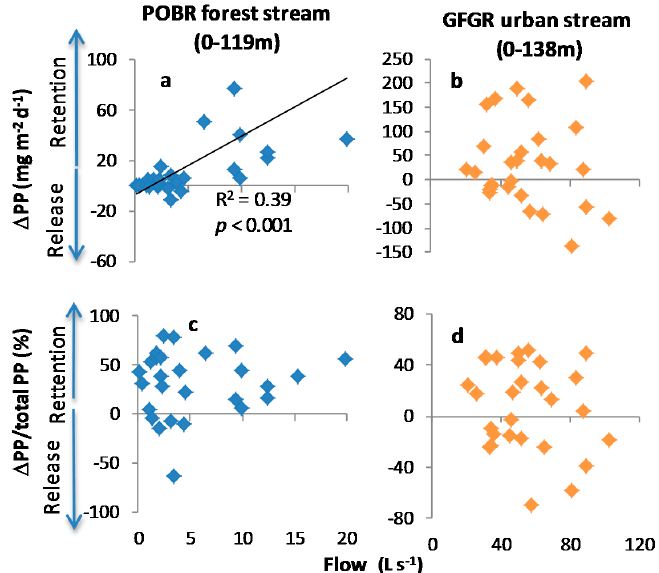
Figure 5. Changes in ( a )–( b ) areal retention rates and ( c )–( d ) retention efficiency of particulate phosphorus (PP) with increasing stream flow in the free ‐ flowing stream reaches of the forest (POBR 0–119 m) and urban stream (GFGR 0–138 m). Mass balances for the suburban stream (SPBR) were not conducted due to the presence of unsampled tributaries.